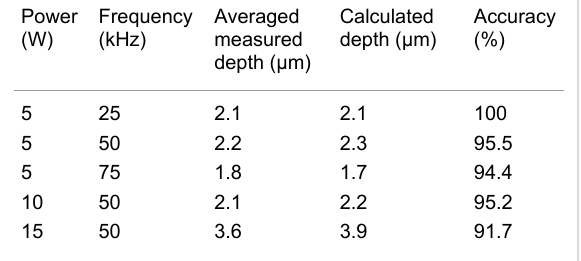
Table 3: Measured and calculated data for the ablation cross-section for Au coated